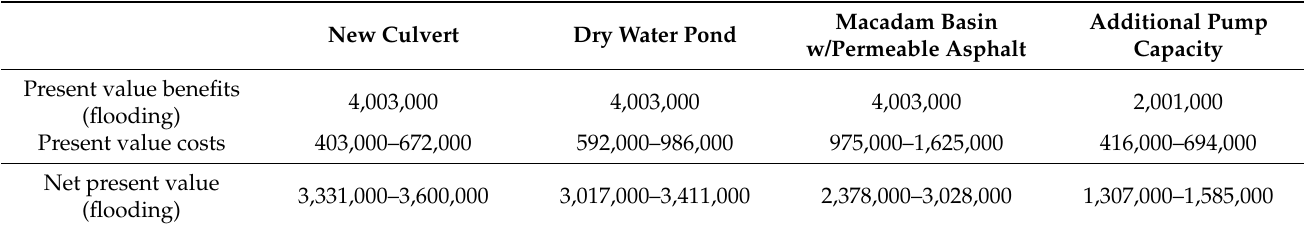
Table 3. Present value of benefits, costs, and net present value when applying ± 25% investment and maintenance costs, in relation to costs in Table 2, SEK in 2017-year